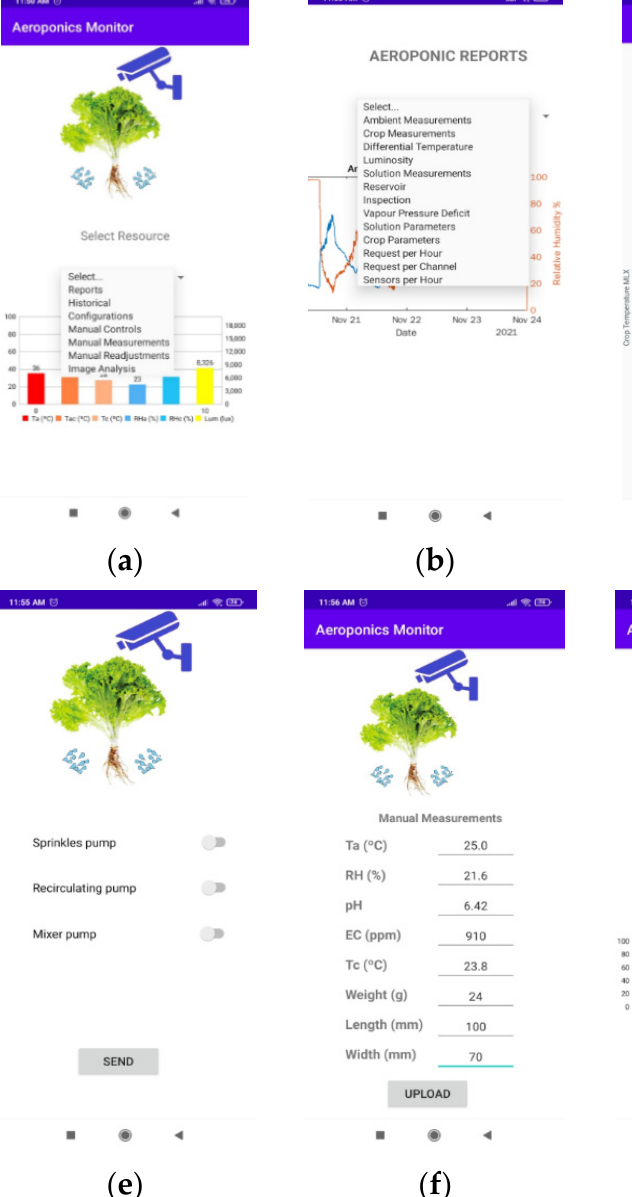
Table 3. Variable—Report Relationship using MATLAB Analysis and Visualization.